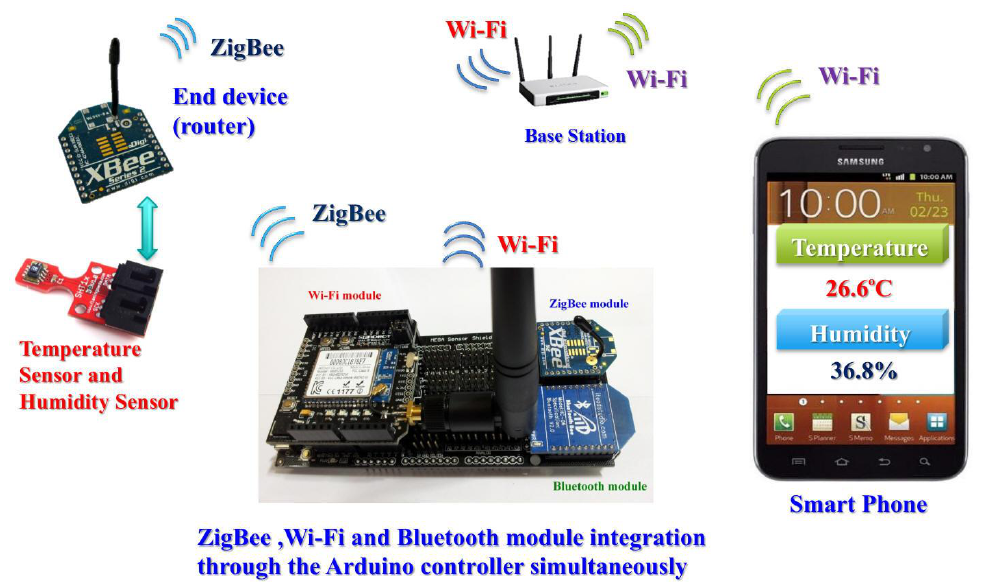
Figure 2. Integrated controller connects devices and sensors by the different